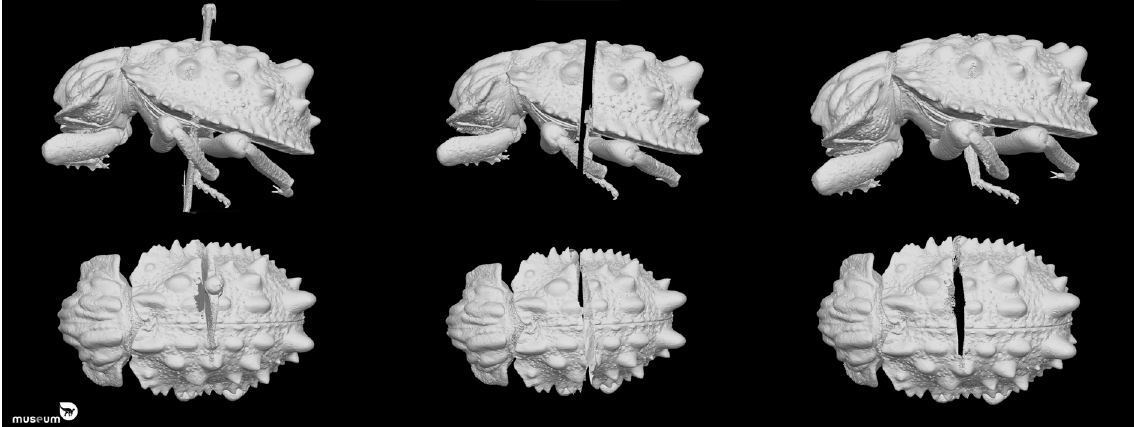
Fig. 6.8. Comparison between different treatments of the µCT model. Top and bottom left: µCT model without any treatment regarding removal of the artefacts https://sketchfab.com/models/169c2b29a1404e5cb5f6b6ea0928d075. Top and bottom in the middle: area affected by the metal artefact quickly cut out in GOM Inspect https://sketchfab.com/models/ f40a108e43ea44d78ca3d04ac41ad0a0; Top and bottom right: Carefully removed the needle through segmentation in Dragonfly 3.5.